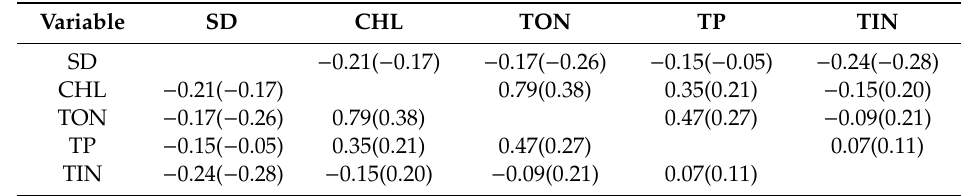
Table 1. Correlation matrices of response variables, from Turner and Seaton data. The water quality response abbreviations are defined in Section 3.